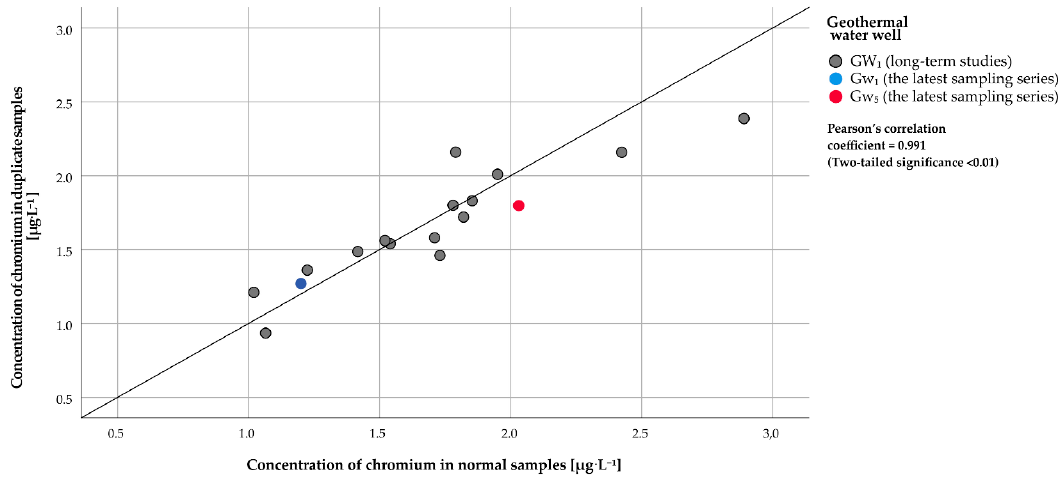
Figure 2. Concentration of chromium in normal and duplicate samples during long-term monitoring.